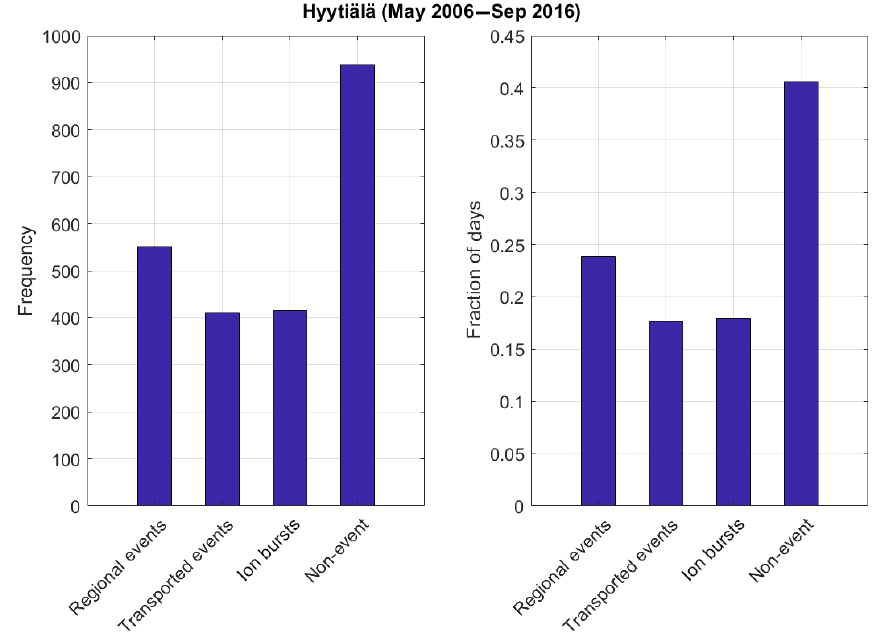
Figure 3. Frequency and fraction of events, ion burst and non-events in Hyytiälä using the new classification